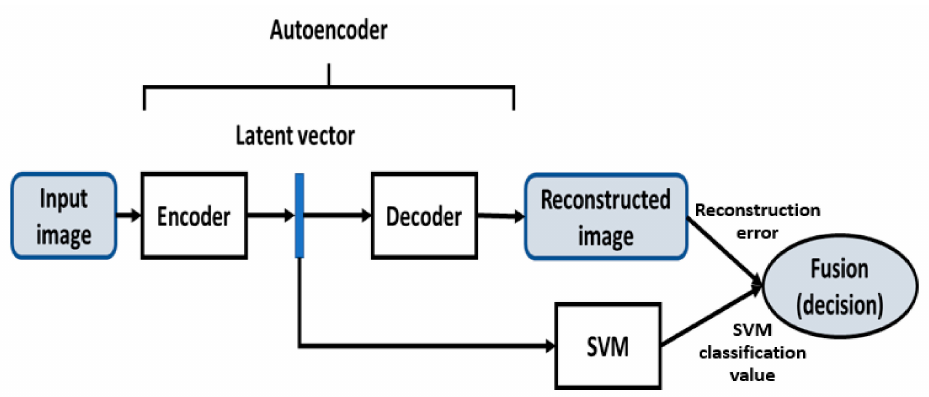
Figure 1. Main schema of the combined